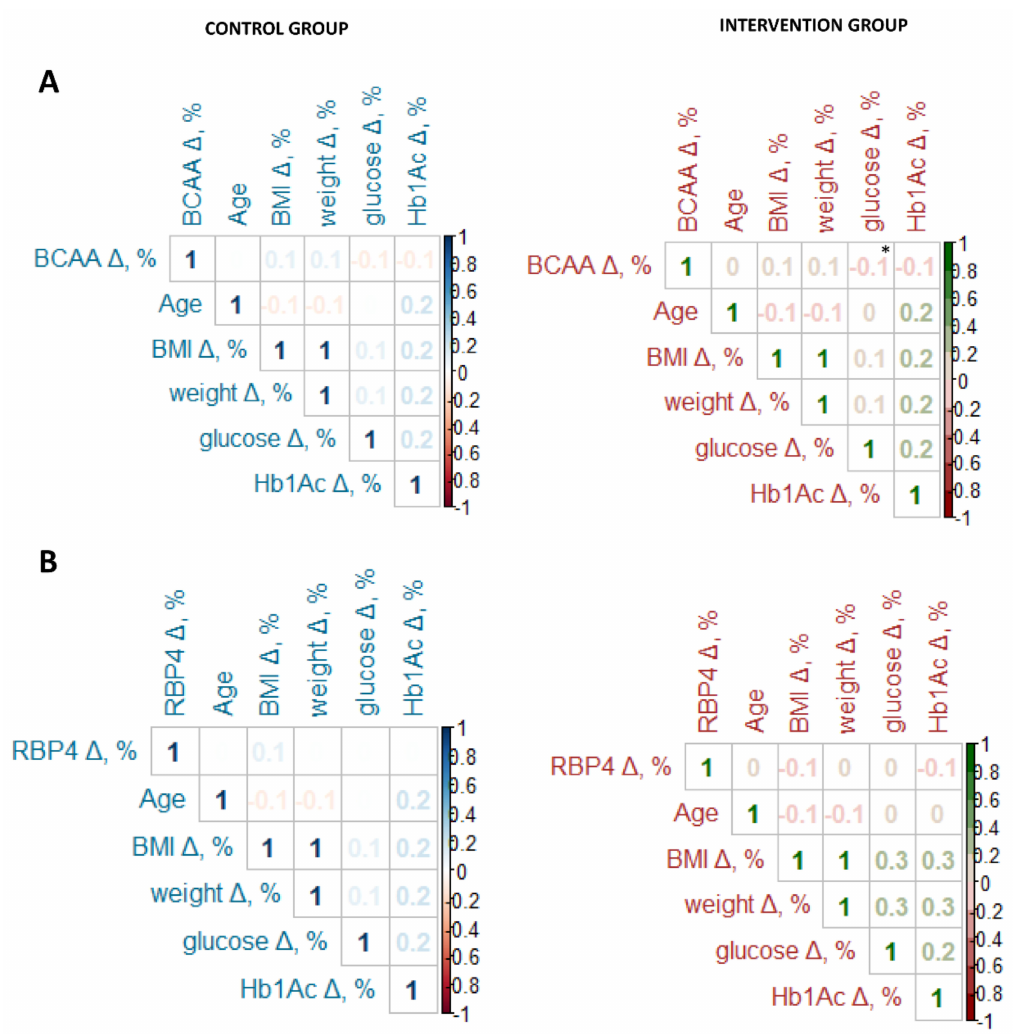
Figure 5. Correlation between BCAA ( A ) or RBP4 ( B ) variation with diabetes markers depending on the group. BCAA: branched amino acid. RBP4: retinol-binding protein 4. BMI: body mass